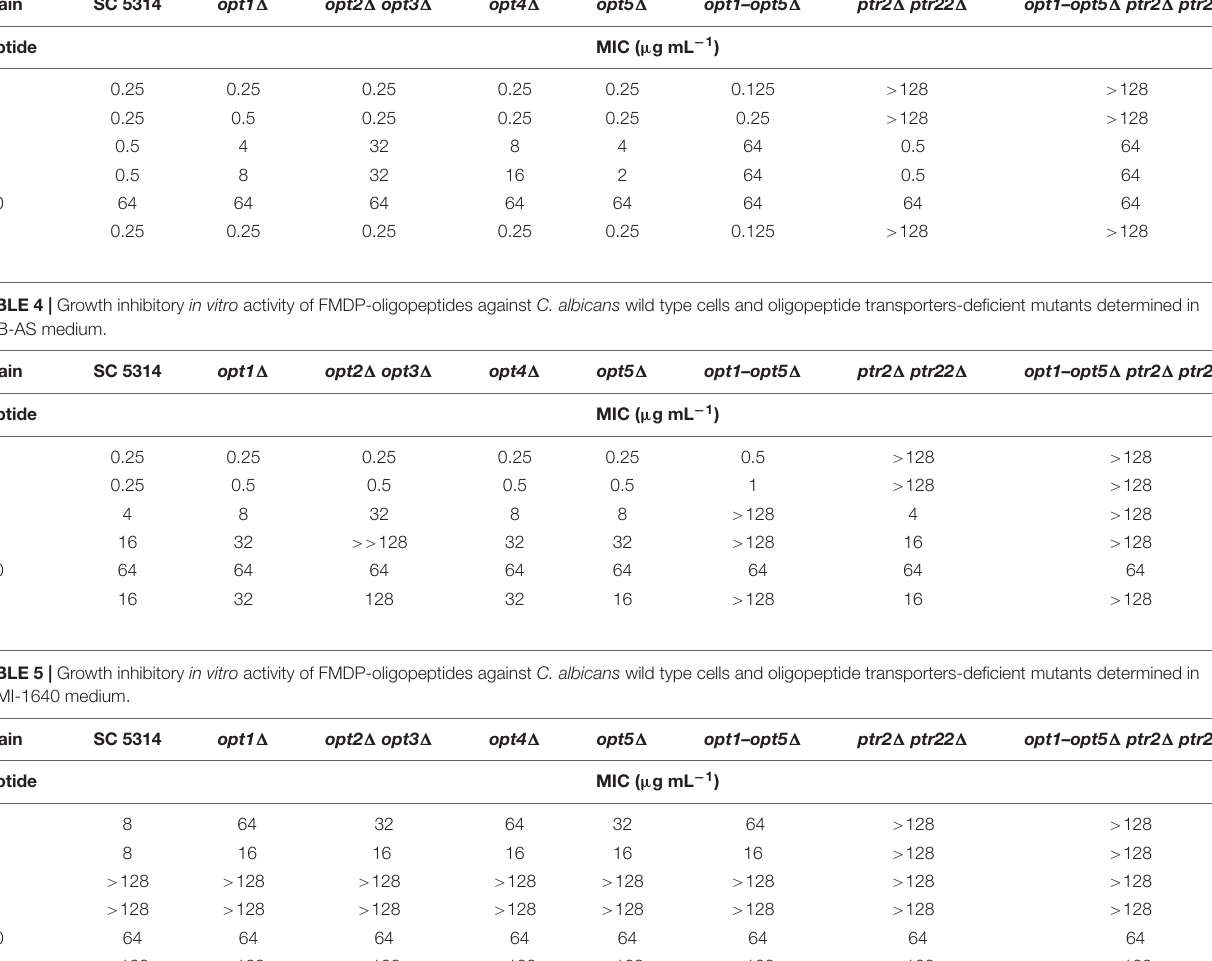
TABLE 3 | Growth inhibitory in vitro activity of FMDP-oligopeptides against C. albicans wild type cells and oligopeptide transporters-deficient mutants, determined in YNB-SG medium. Strain